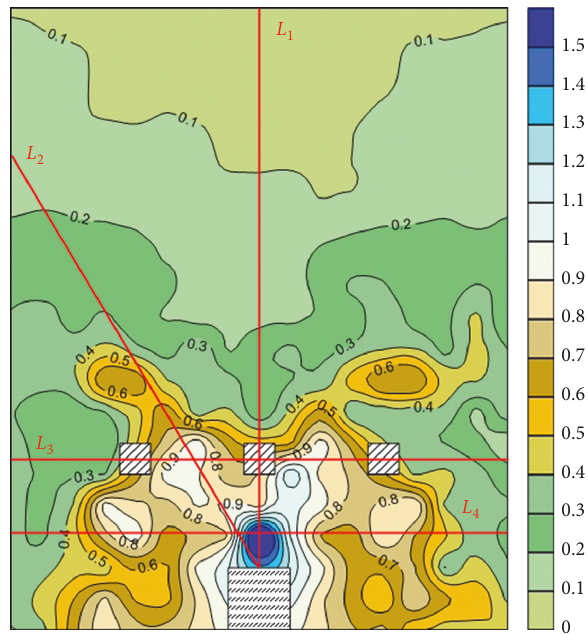
Figure 17: The contour map of ζ on T3-353.